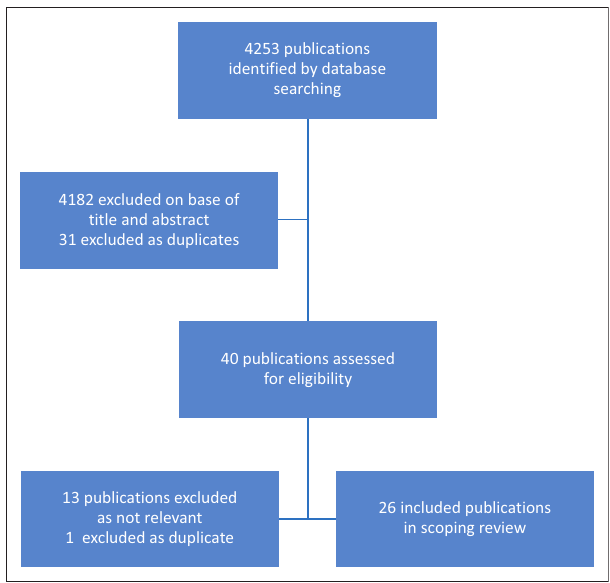
FIGURE 1: Flow diagram for selection of